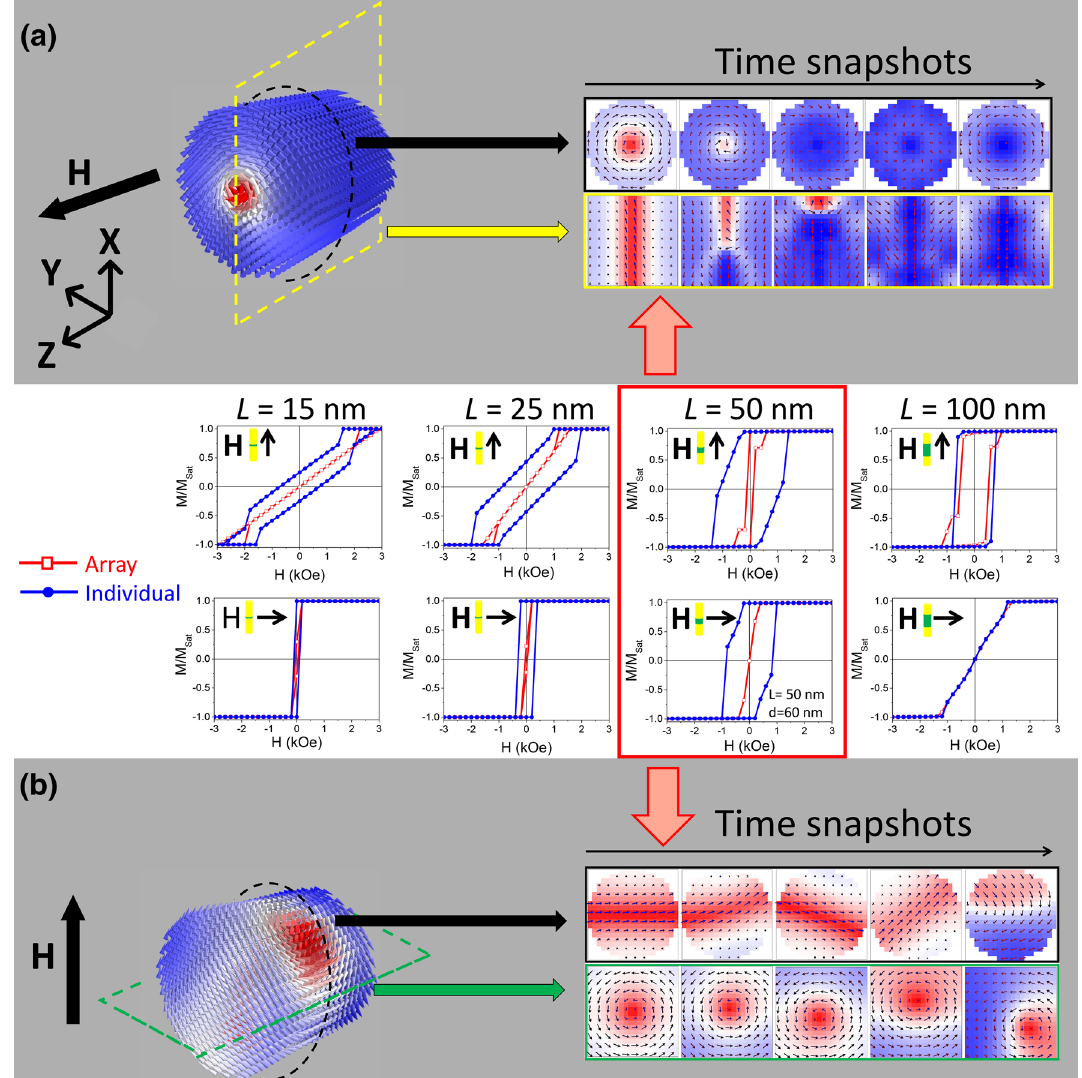
Figure 3. Simulated magnetic hysteresis loops of arrays (red opened symbols) versus individual (blue closed symbols) Ni NWs with 15, 25, 50 and 100 nm in length, when applying the magnetic field parallel (upper plots) and perpendicular (lower plots) to the NWs’ long axis. ( a ) and ( b ) 3D and cross-sectional representations (central x-, y- and z-slices) of time snapshots during magnetization reversal of an individual Ni NW with 50 nm in length and 50 nm in diameter, when applying the magnetic field ( a ) parallel and ( b ) perpendicular to the NWs’ long axis. ( a ) Illustrates the formation of a skyrmion tube and the propagation of a vortex domain wall with alternating chirality from clockwise to counter-clockwise; while ( b ) illustrates reversal by spiral rotation of a vertical vortex. The color scale is the same as in Fig. 2, except that in ( b ) M z is replaced by M x